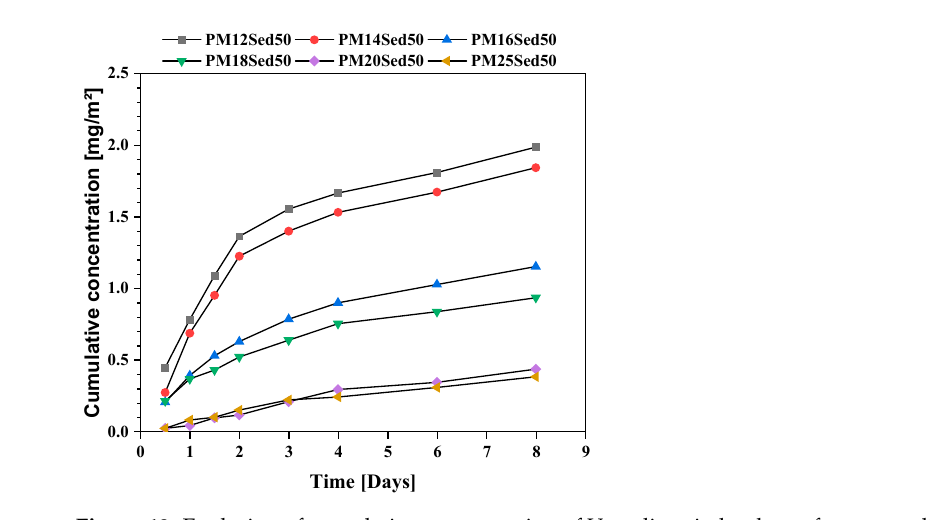
Figure 13. Evolution of cumulative concentration of Vanadium in leachates from monolithic polymer mortars containing 50% of sediments in their matrices.